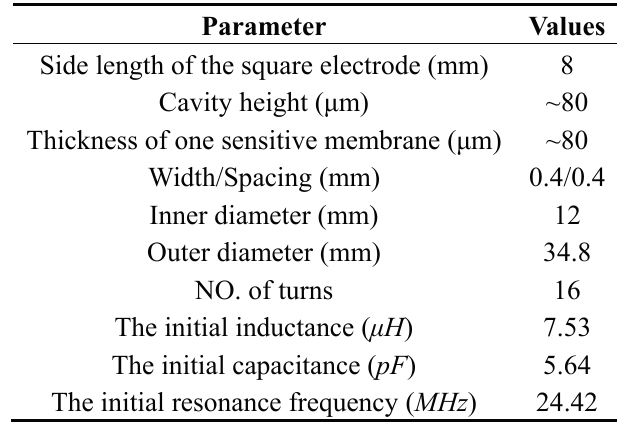
Table 1. Design parameters of the capacitor and